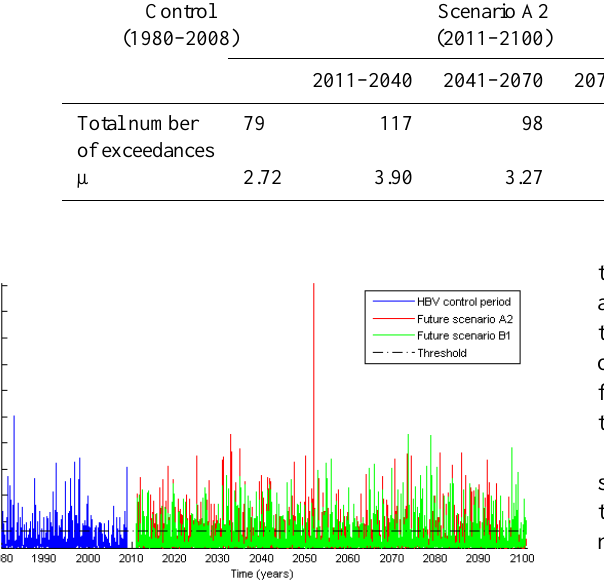
Figure 6 Time series of the discharge values in the Alt Llobregat sub-basin. The HBV simulations for the control (1980-2008) period (blue) is plotted. The future (2011-2100) discharge series computed with the HBV model for the A2 (red) and B1 (green) SRES scenarios are also presented. The dashed black line represents the threshold of 13 m 3 ·s -1 .